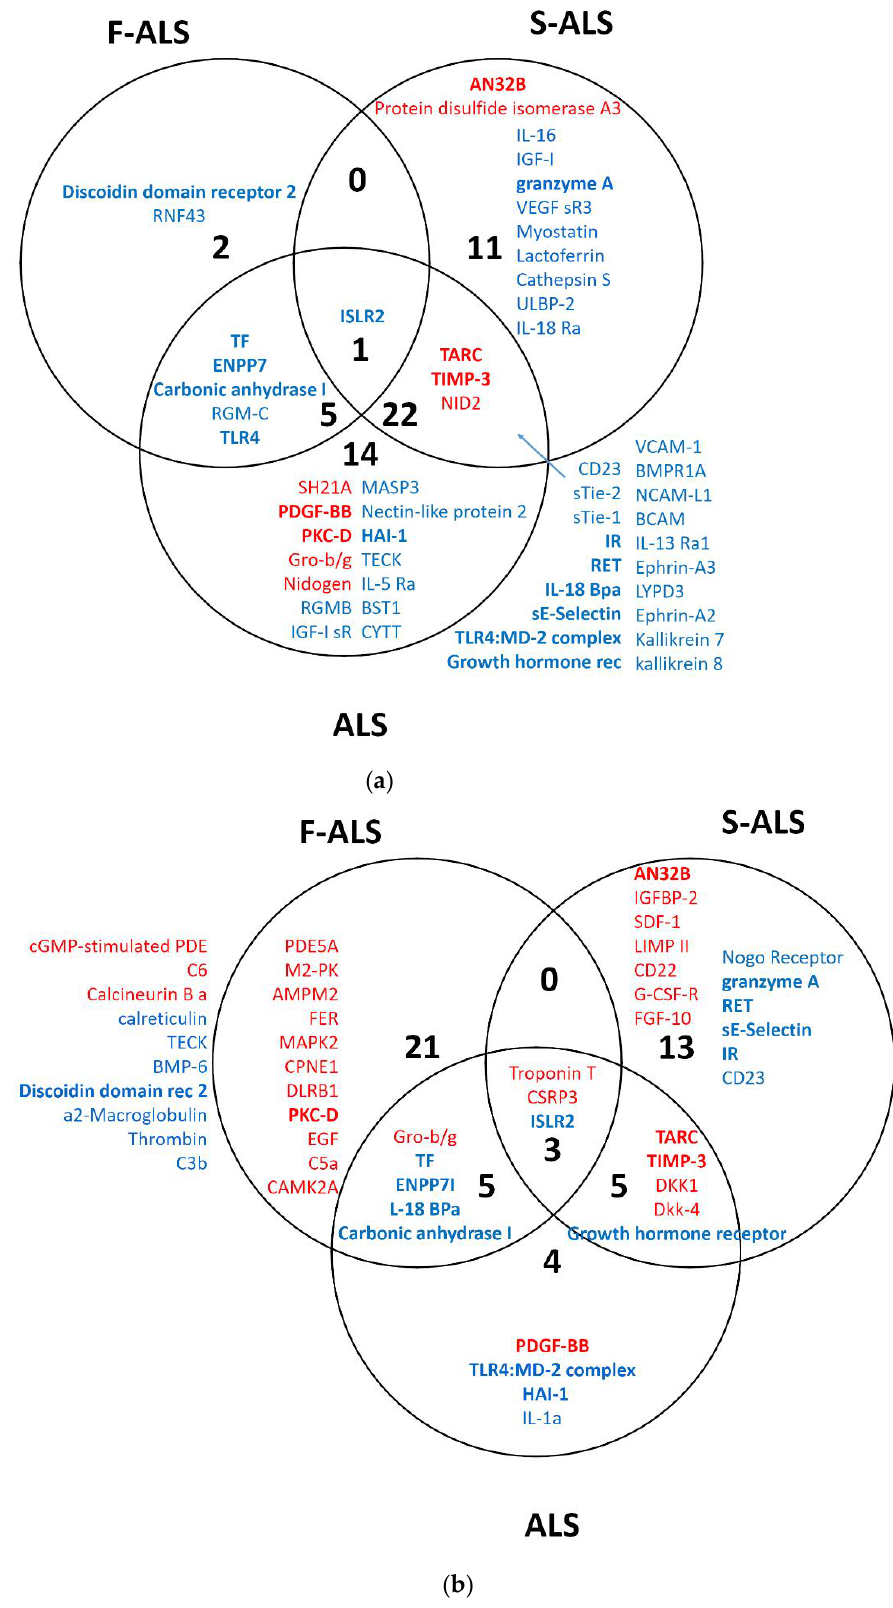
Figure 3. Venn diagram of overlapping proteins from a comparison of the proteomic results obtained for SAM ( a ) and limma ( b ) analysis. In bold are upregulated (red) or downregulated (blue) proteins identified by two statistical analysis methods.